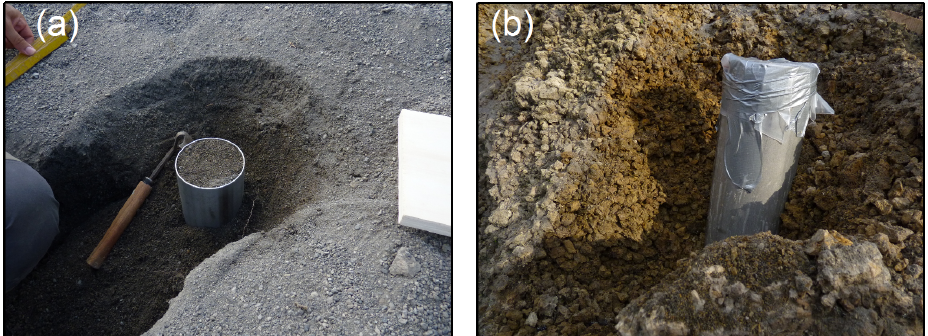
Figure A1. (a) Sampling the 1888–1890 tephra fallout deposit with a 30cm steel tube. We cleaned the entire deposit around the tube to extract it with minimum disturbance. (b) Sampling the PAL-D tephra fallout deposit with a 30cm steel tube. The tube is covered with a plastic cover and plastic tape before extracting it from the deposit with a basal support.